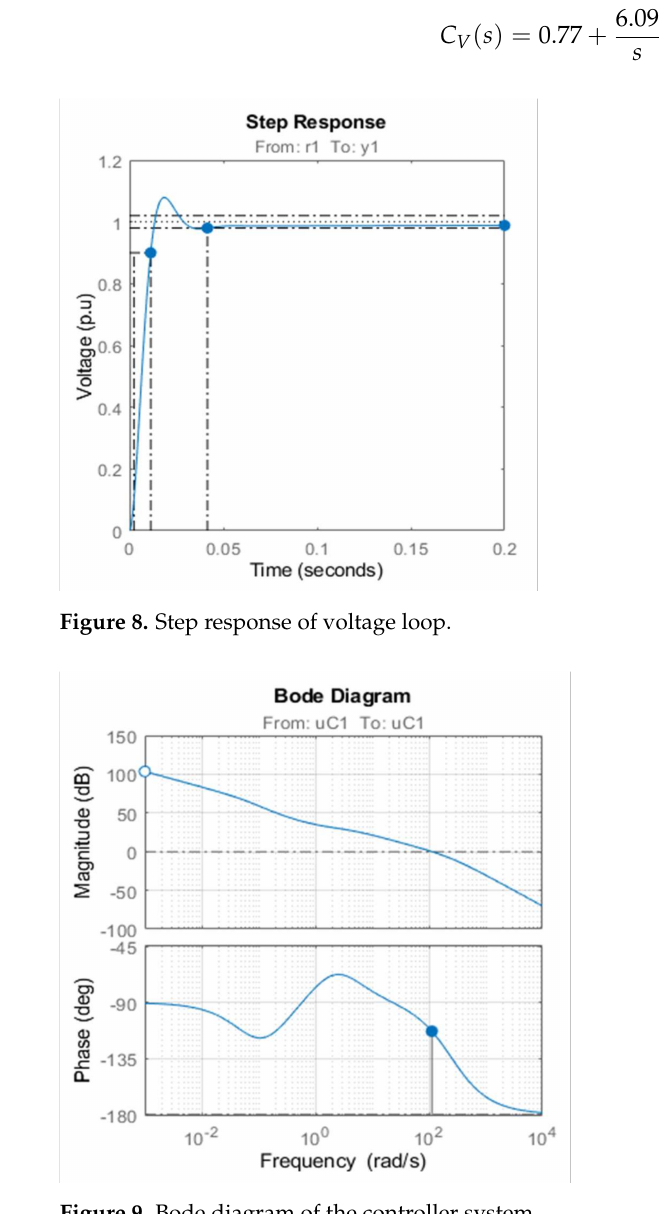
Figure 9. Bode diagram of the controller